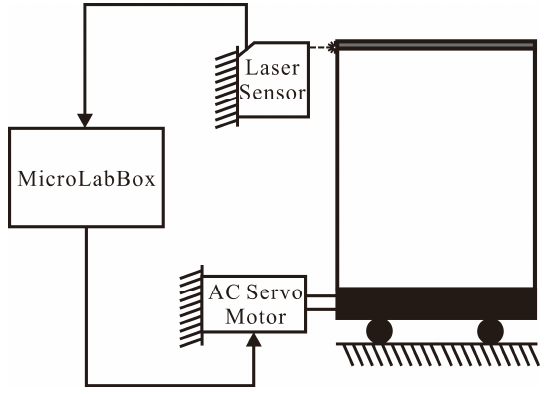
Figure 8. Wiring diagram.